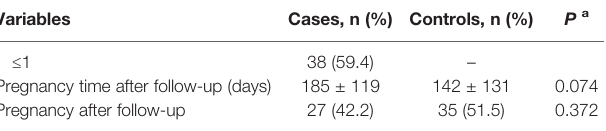
TABLE 1 | Clinical and demographic characteristics of endometrial polyp patients and healthy